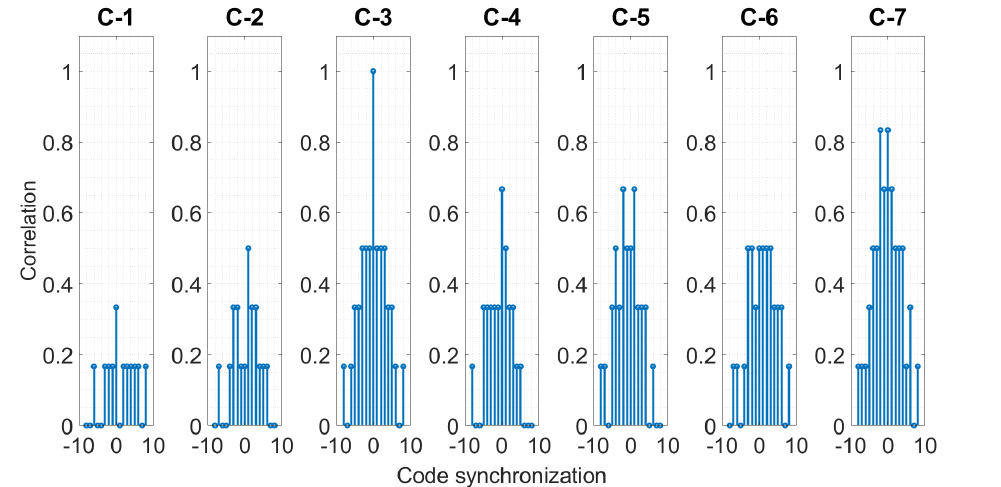
Figure 15. Correlation of PN code 3 with the rest of the PN codes. PN code 3 was selected as the code intended for the transmitter-receiver pair for the simulation results in Figure